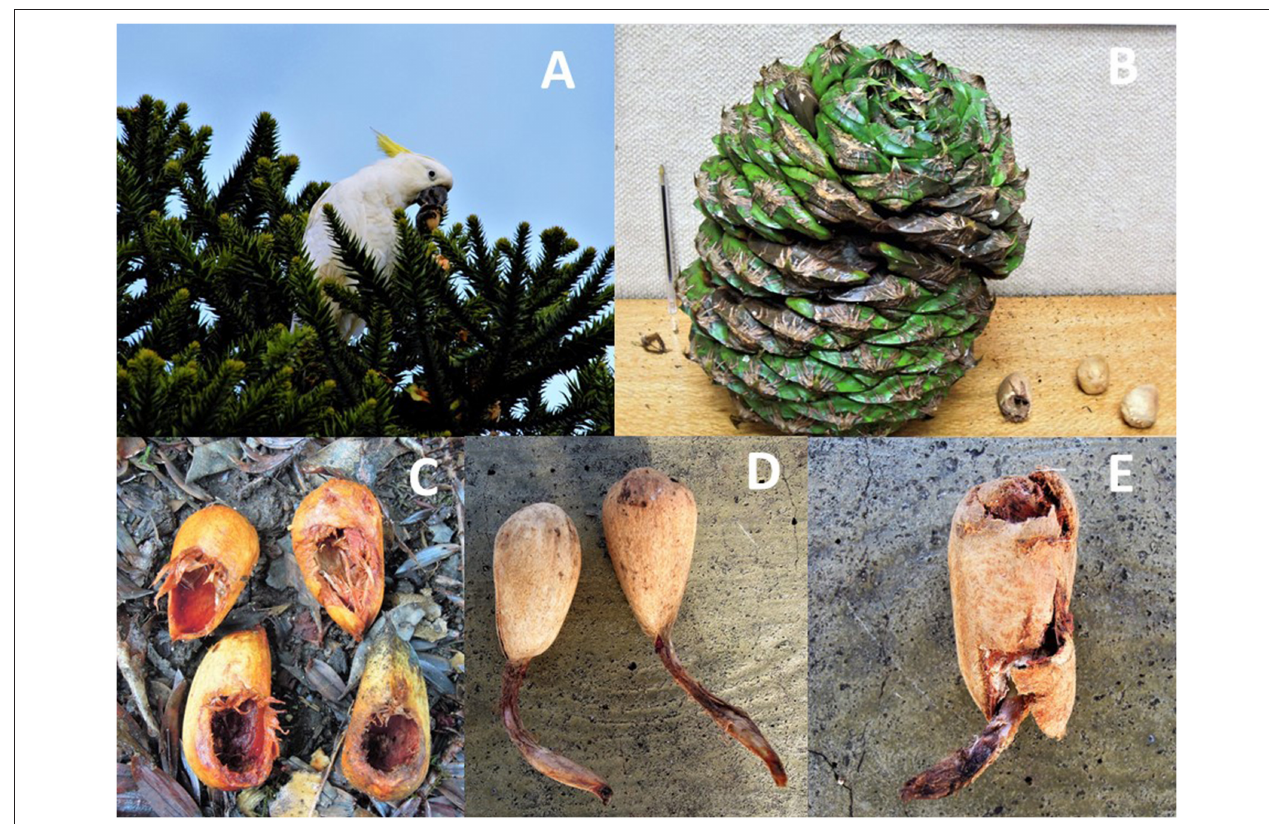
FIGURE 1 | A sulfur-crested cockatoo handling a Bunya pine ( A. bidwillii ) seed (A) after extracting it from the large and strong female cone (B) . Note the size of the cone related to the size of the seeds, in the bottom right corner of the picture. Cockatoos open the pericarp to consume the endosperm in a characteristic way (C) . Entire (D) and partially-eaten (E) seeds germinating after dispersal by cockatoos (Pictures: GB and